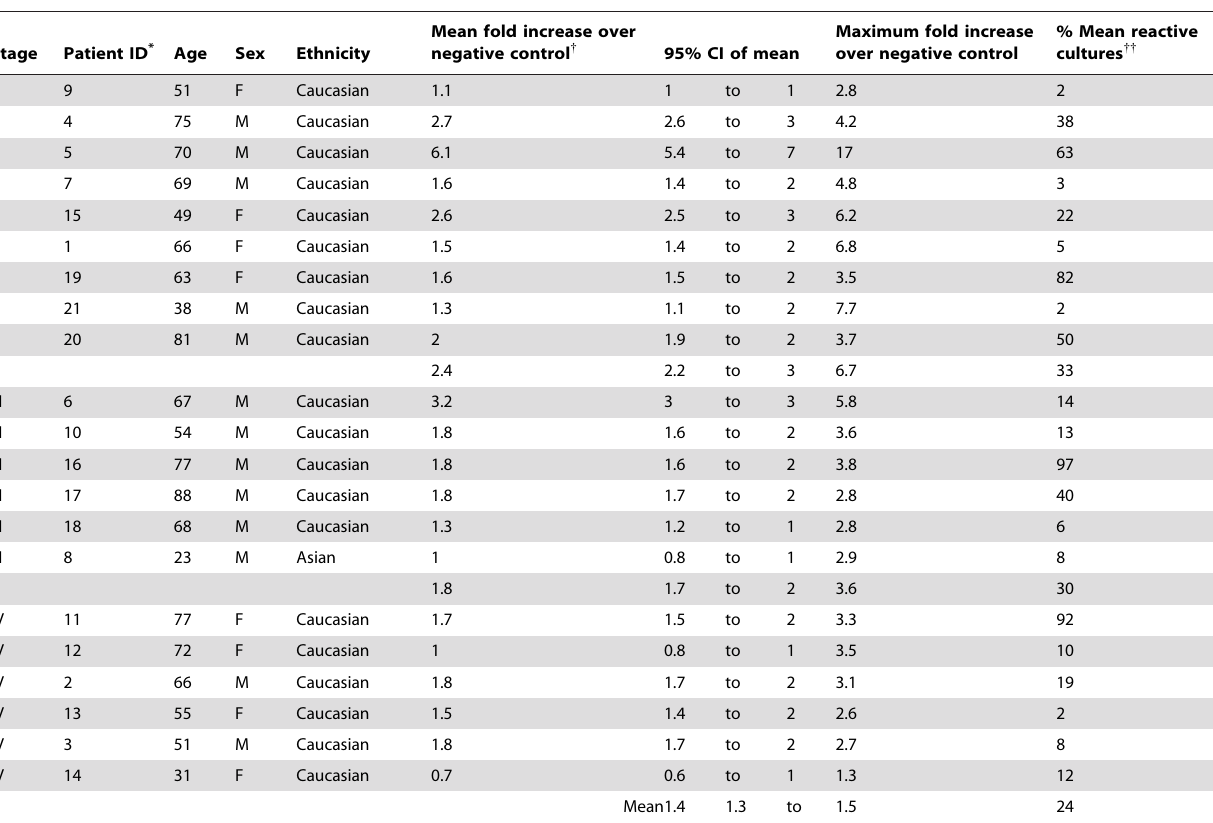
Table 1. Reactivity of patient-derived antibody-producing B cell cultures to A-375 metastatic melanoma cells.